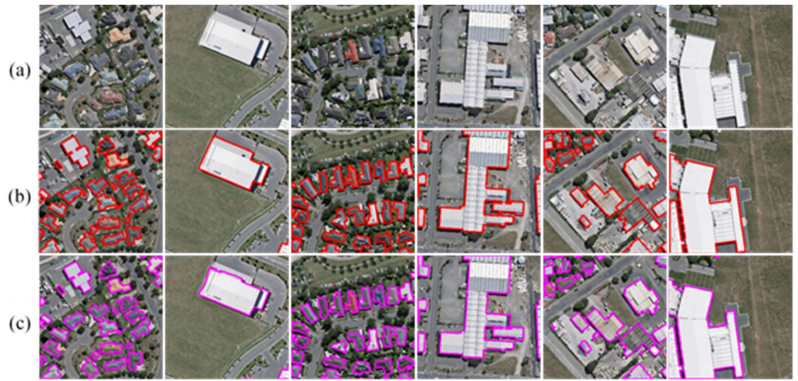
Figure 12. Results of building edge extraction on the WHU dataset. ( a ) Images. ( b ) Labels. ( c ) Results.